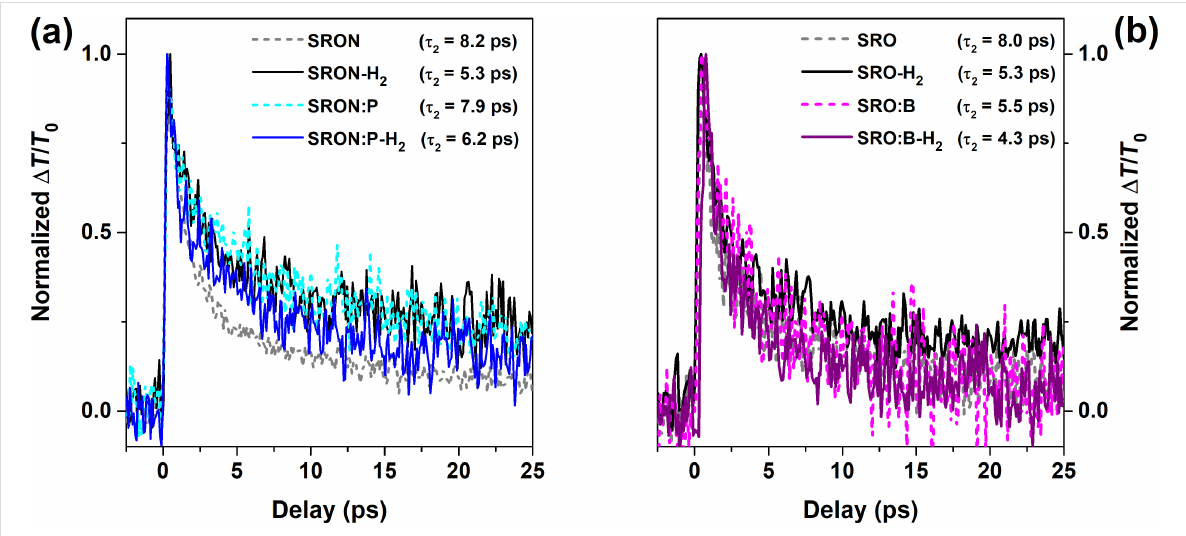
Figure 5: Transient transmission (TT) dynamics from pump-probe measurements at room temperature of ≈ 4.5 nm Si NCs from (a) SRON:P and P-free SRON and (b) SRO:B and respective B-free SRO. All samples are measured before and after H 2 -passivation. The curves are normalized for better comparability of the decay dynamics (although no significant or even doping-related differences exist in the initial signal intensity of the sam- ples). The time constants of the component τ 2 of the two-exponential fits (not shown for clarity) are given in the figure. The presence of P- or B-atoms in the NCs does not increase the speed of carrier recombination, as would be expected from the presence of dopant-induced free